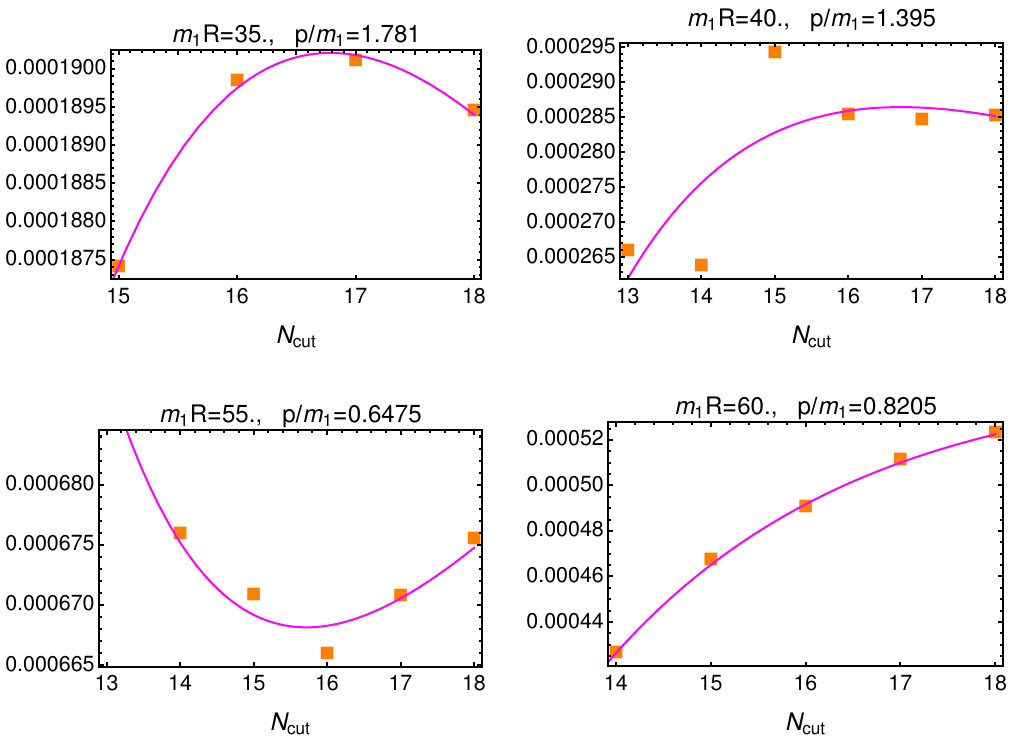
Figure 9 . Illustration of cut-o(cid:11) extrapolation in the case of two-particle overlaps K 11 ( p ) of the Ising Field Theory. The (cid:12)rst three panels show that problems with the (cid:12)t can occur at various volumes and energies. The fourth panel illustrates that a precise (cid:12)t can also be obtained at large